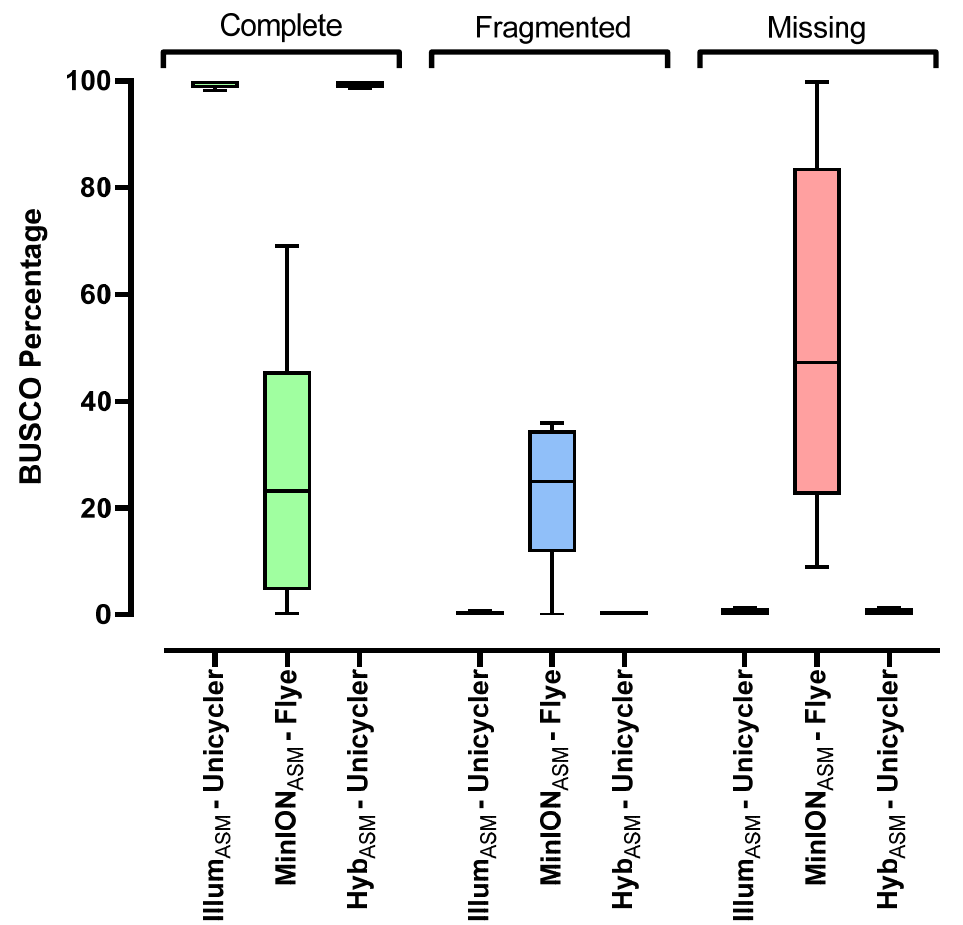
Figure 1. Box plots for BUSCO results of the best-performing assemblers. Illum ASM was produced using Unicycler, MinION ASM using Flye and Hyb ASM was created using Unicycler. Each box extends from Min to Max values in each group and the middle black line in each box indicates the mean value. The BUSCO percentage for mixed samples is not included in the graph.